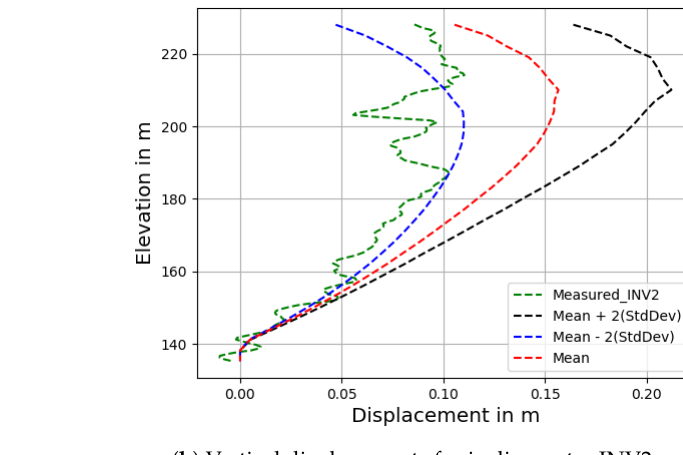
Figure 5. Confidence intervals for numerical vertical